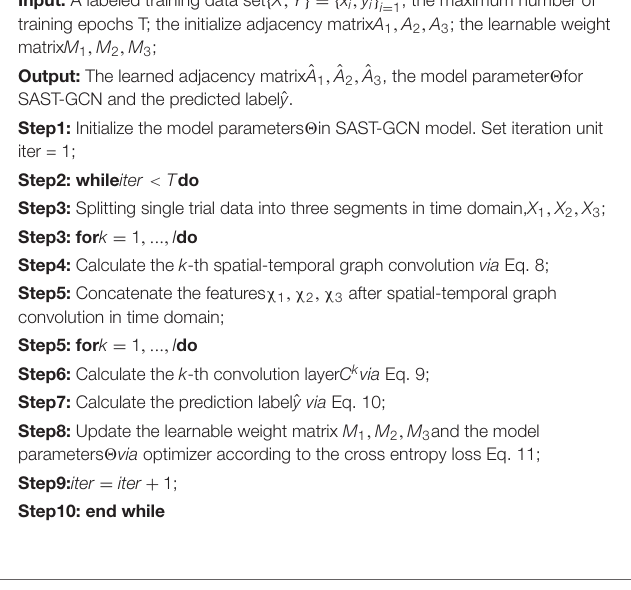
ALGORITHM 1: The training process of